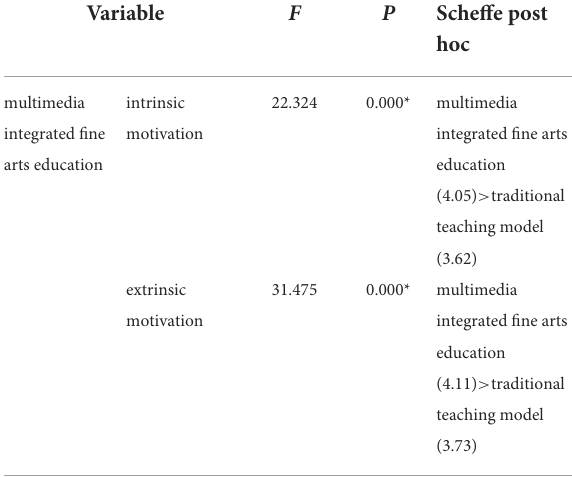
TABLE 2 Difference analysis of multimedia integrated fine arts education in learning